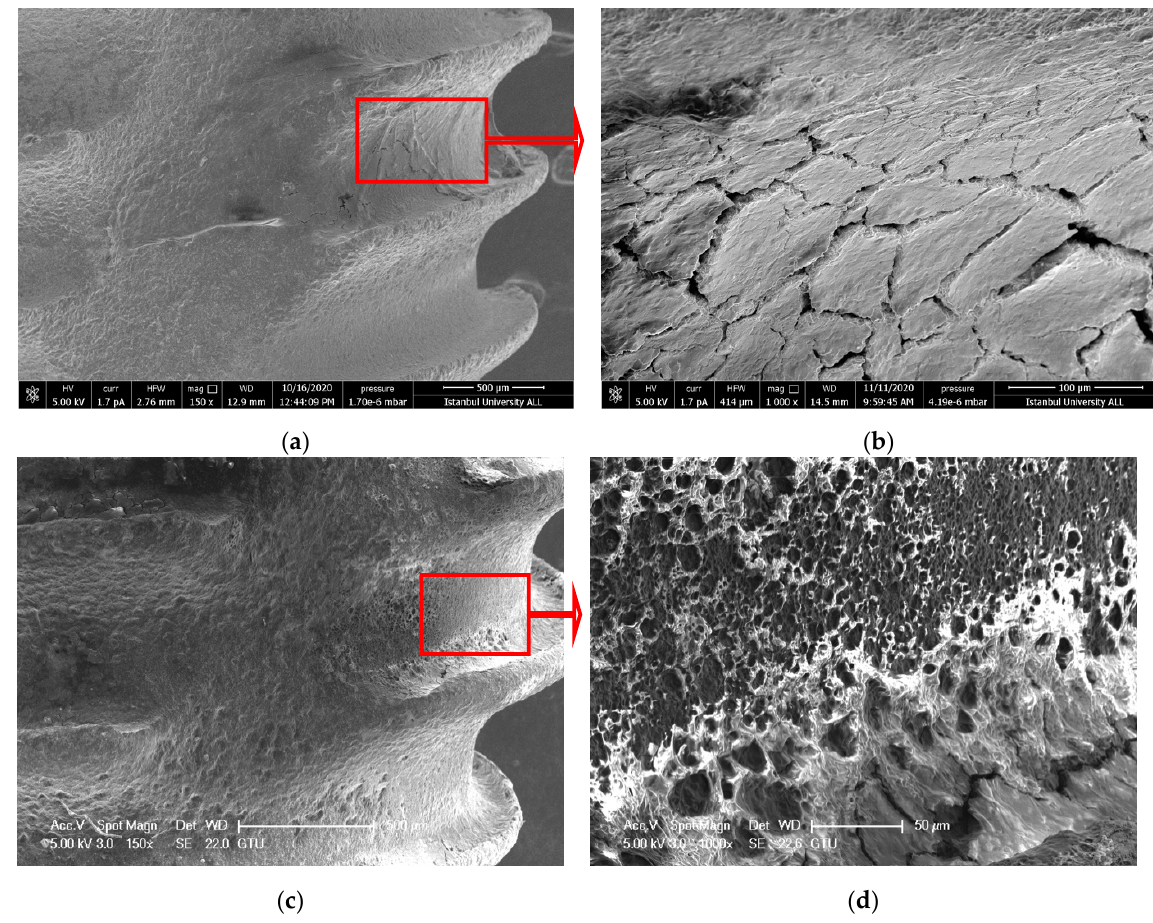
Figure 7. ( a , b ) SEM images showing the topography of untreated failed implant surfaces in ErCrL-2 group (150× and 1000× magnification); ( c , d ) after intervention (150× and 1000× magnification). Red arrows show the further magnification area.